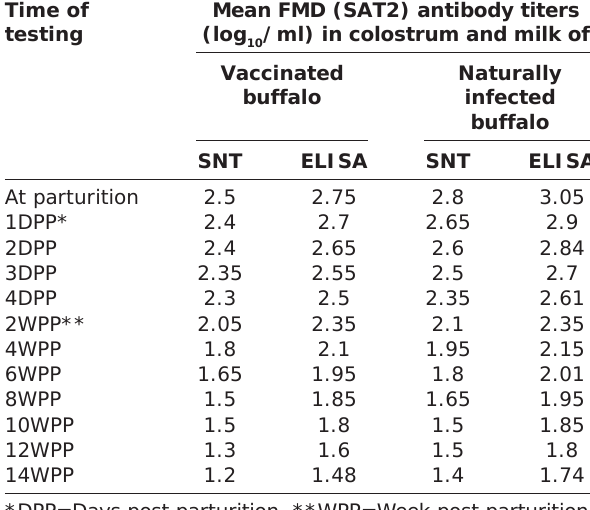
Table-4: Tracing of the mean FMD (SAT2) antibody titers of colostrum and milk of buffalo cows. Time of Mean FMD (SAT2) antibody titers testing